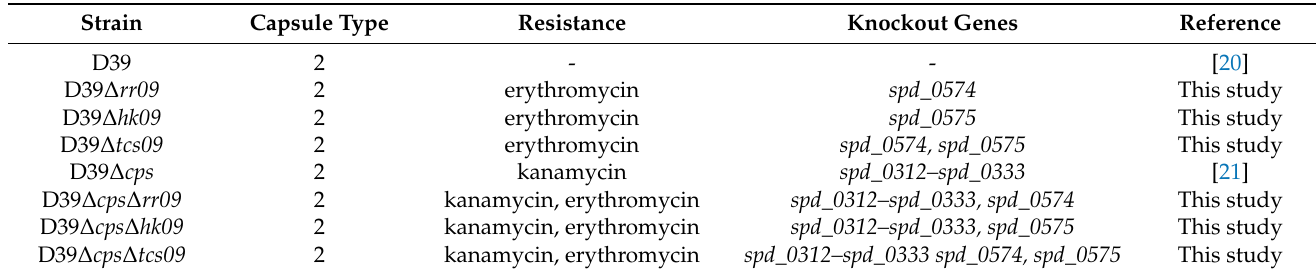
Table 1. S. pneumoniae wild-type strains and mutants used in this